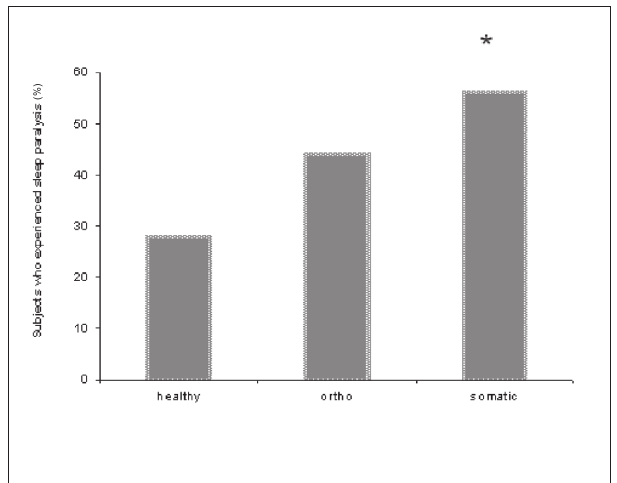
Fig. 1. The bars represent the percentages of healthy subjects (healthy, N=50), orthopaedic patients (ortho, N=41) and patients with multiple somatic complaints (somatic, N=25) who reported ISP (*p<0.05 v. healthy subjects (controls)). Twenty- eight per cent of healthy subjects, 44% of orthopaedic patients and 56% of patients with multiple somatic complaints reported ISP. Chi-square testing showed that ISP was significantly com- moner among patients with multiple somatic complaints com- pared with the controls.